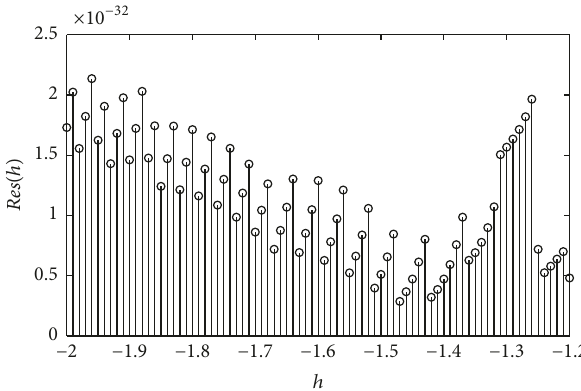
Figure 2: The approximate optimal ℎ ( ℎ = −1.47 ) for 𝑁 = 15 for Example